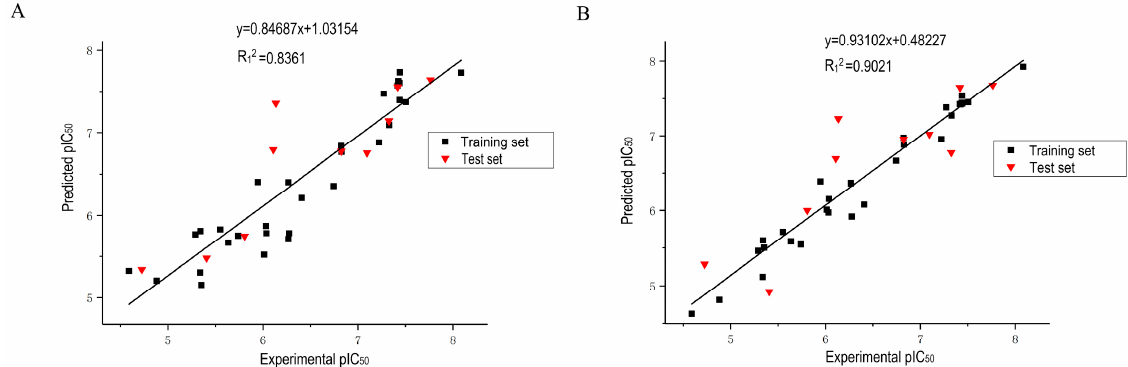
Figure 2. Scatter plots of experimental pIC 50 values and predicted pIC 50 values for CoMFA model ( A ) and CoMSIA model ( B ).